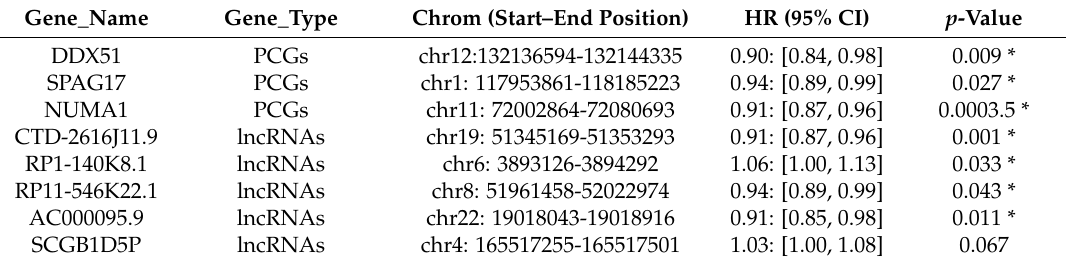
Table 5. Important prognostic biomarkers and univariate overall survival